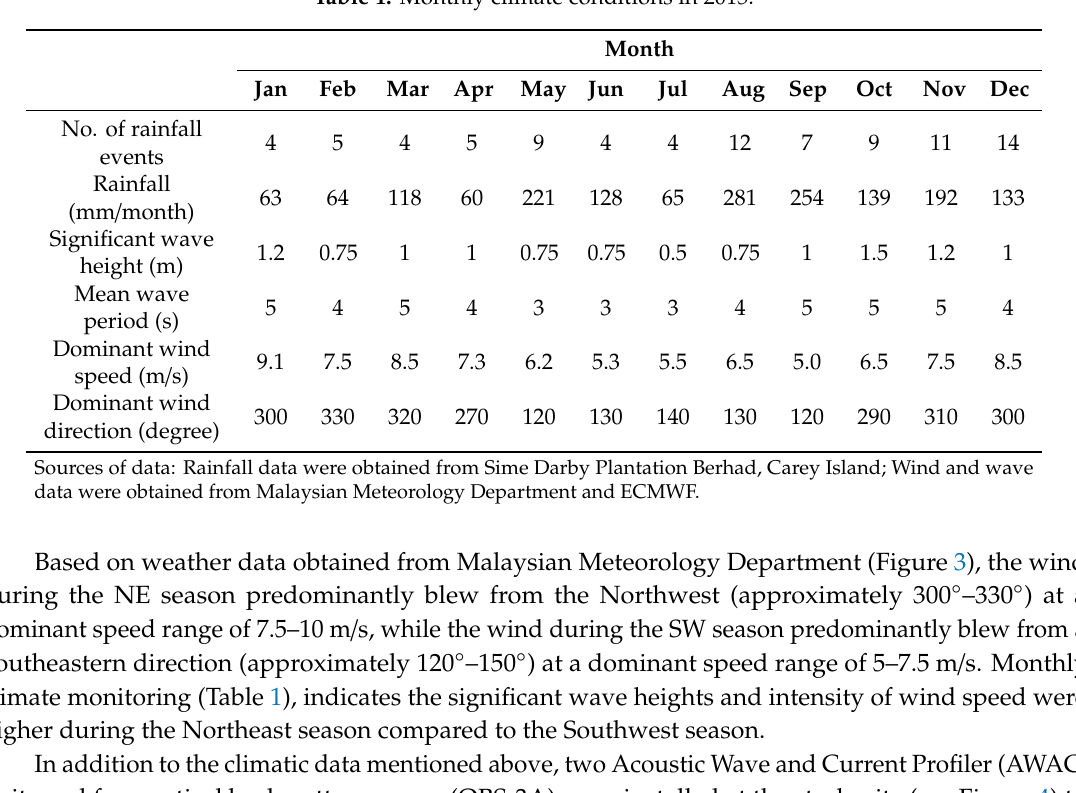
Table 1. Monthly climate conditions in 2015.